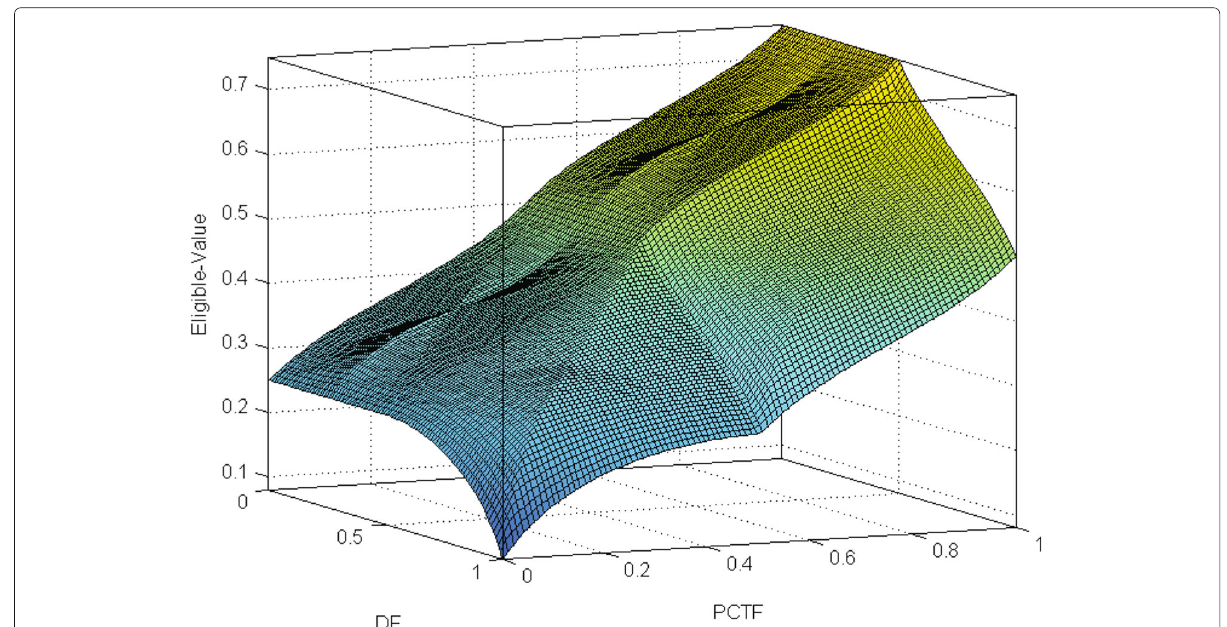
Fig. 12 Impact of DF and PCTF on